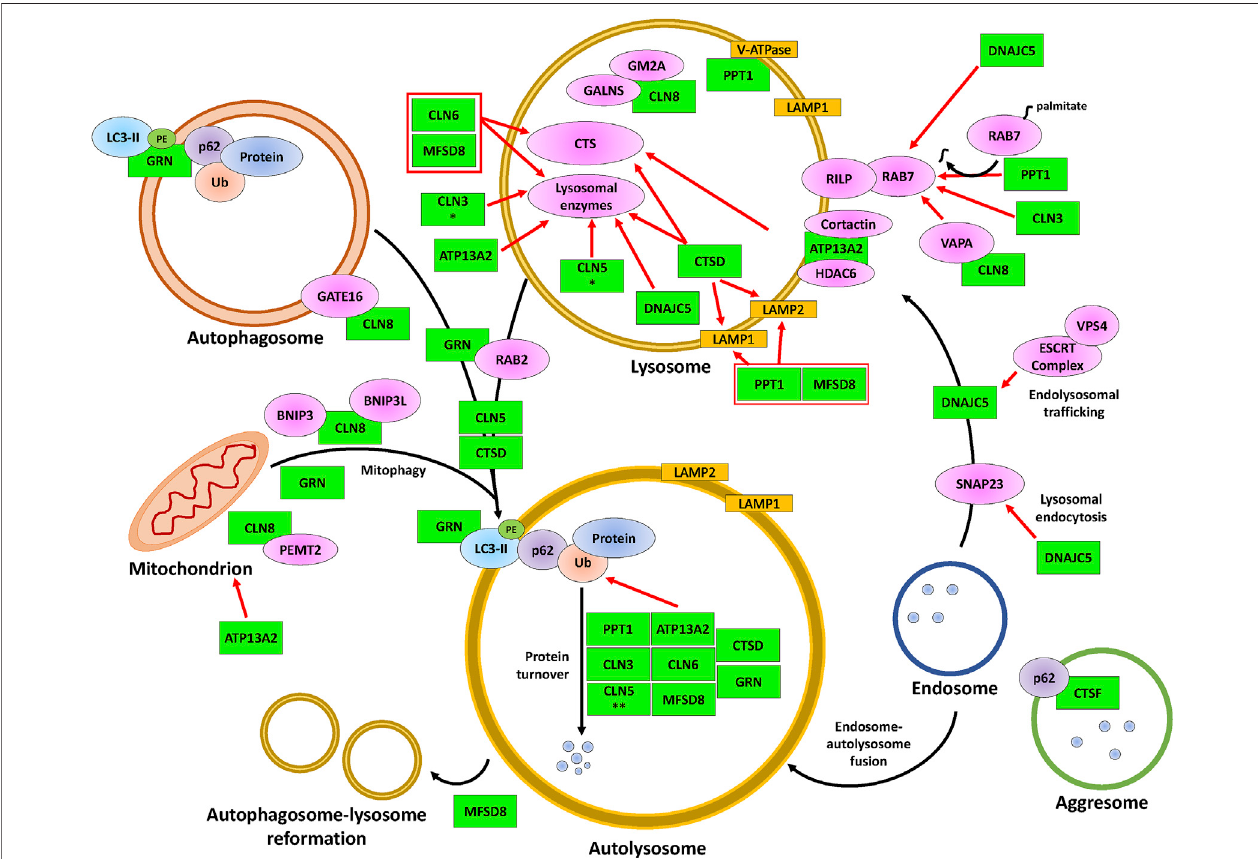
FIGURE3| The involvementofCLNproteins inautolysosome formation, cargodegradation, autophagic lysosome reformation, and mitophagy. TheCLN proteins (green) modulate various proteins (magenta, yellow, orange) that impact the indicated processes within lysosomes, such as intraluminal acidi fi cation and enzymatic degradation, and the fusion of lysosomes with autophagosomes(denoted as autolysosomes) or with mitochondria (known as mitophagosomes, not represented here). While DNAJC5 is involved in regulating endolysosomal traf fi cking and the fusion between endosomes and autolysosomes, MFSD8 is involved in ALR. The black arrowsindicatetheautophagicprocessesstartingfromautolysosome/mitophagosomeformationtoALR.Redarrowsindicatesupportingevidenceoftheinvolvementof a CLN protein within the latter processes ofautophagy. Protein overlaps are representative ofprotein-protein interactions. * indicates the observation wasmade only for the D.melanogaster homologand**indicatestheobservationwasmadeonlyforthe D.discoideum homolog.NotethatthepositionsoftheCLNproteinsdepictedinthe fi gure are not necessarily representative of their actual localization in the cell. Please refer to Table 1 for information on the localizations of the different CLN proteins. ATP13A2, polyamine transporting ATPase 13A2; BNIP3, BCL2/adenovirus E1B 19 kDa protein-interacting protein 3; BNIP3L, BCL2/adenovirus E1B 19 kDa protein- interacting protein 3-like; CLN3, ceroid lipofuscinosis neuronal 3; CLN5, ceroid lipofuscinosis neuronal 5; CLN6, ceroid lipofuscinosis neuronal 6; CLN8, ceroid lipofuscinosis neuronal8;Cortactin,cortactin;CTS, cathepsin B/D/Z; CTSD,cathepsinD; CTSF,cathepsinF; DNAJC5, DnaJheatshock protein family Hsp40 member C5; ESCRT complex, endosomal sorting complex required for transport complex; GALNS, N-acetylgalactosamine-sulfate; GATE16, GABA type A receptor-associated protein-like 2; GM2A, GM2 ganglioside activator; GRN, progranulin; HDAC6, histone deacetylase 6; LAMP1, lysosomal-associated membrane 1; LAMP2, lysosomal- associated membrane 2; LC3-II, lipid-attached membrane-bound LC3; Lysosomal proteins, PPT1/TPP1/ β -glucuronidase/ β -hexosaminidase/Saposin C/D; MFSD8, majorfacilitator superfamily domaincontaining8;p62, p62/sequestosome1;PE,phosphatidylethanolamine;Protein,proteincargo;PEMT2,phosphatidylethanolamine N-methyltransferase 2; PPT1, palmitoyl protein thioesterase 1; RAB2, ras-related protein Rab-2A; RAB7, ras-related protein Rab-7A; RILP, RAB-7A-interacting lysosomal protein; SNAP23, synaptosomal-associated protein 23; Ub, ubiquitin; V-ATPase, vacuolar-type ATPase; VAPA; vesicle-associated membrane protein A; VPS4; vacuolar protein sorting